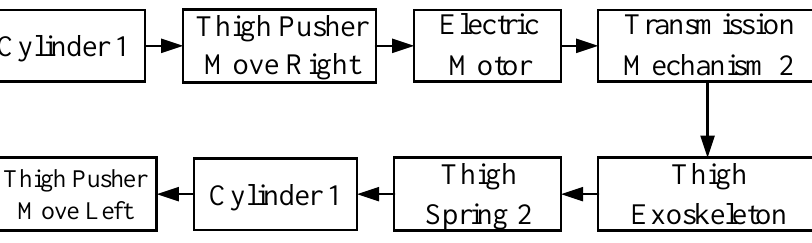
Figure 4. The rehabilitation training process of the hip joint.